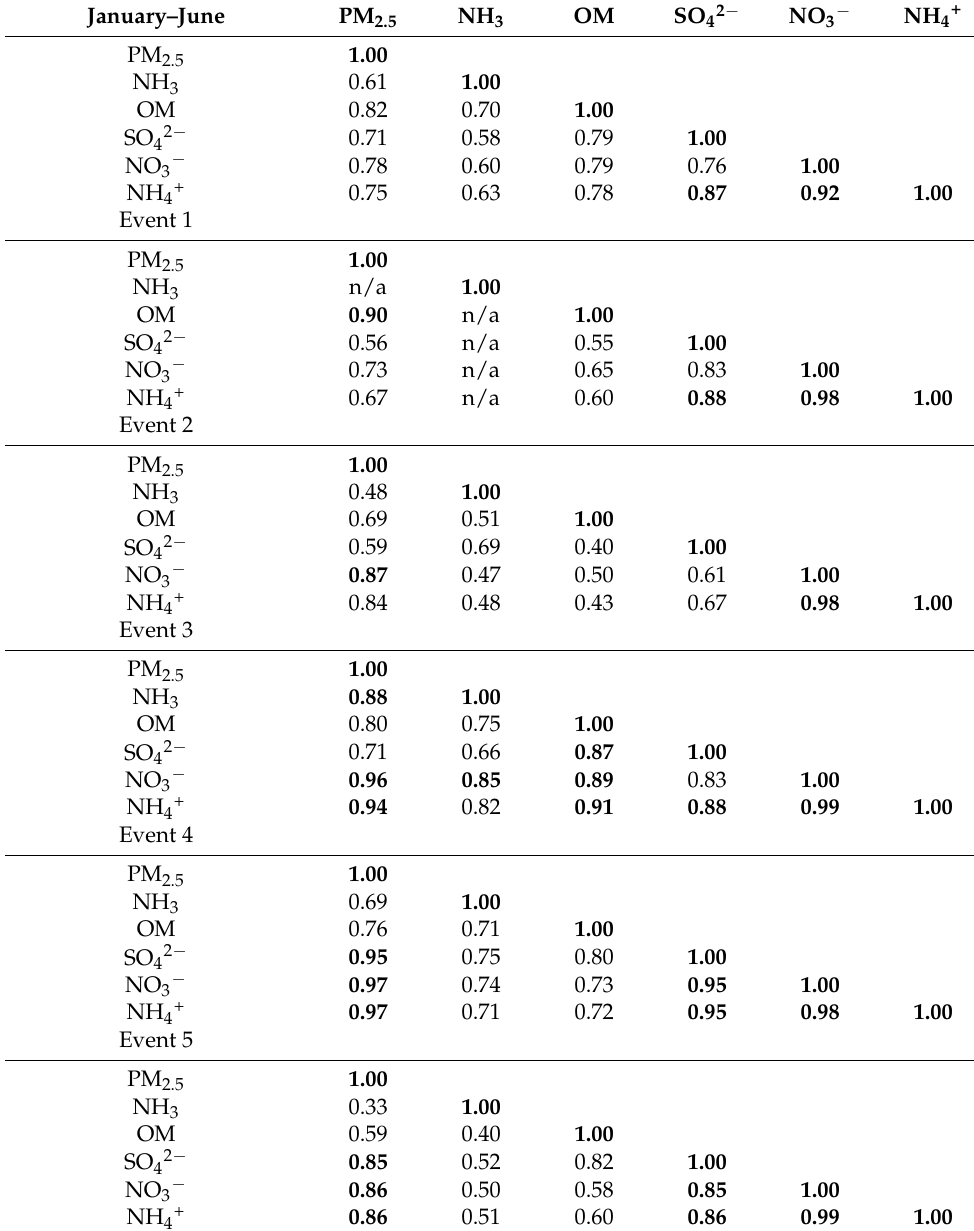
Table 2. Spearman’s rank correlation coefficients ( r s ) between particulate matter (PM 2.5 ), ammonia (NH 3 ), and particulate species (OM: organic matter, SO 42 − : sulfate, NO 3 − : nitrate, and NH 4+ : ammonium) for the period of study (January–June 2020, and the five pollution events). r s > 0.85 are in bold. NH 3 concentrations derived from the mini-DOAS (differential optical absorption spectroscopy) below detection limits were